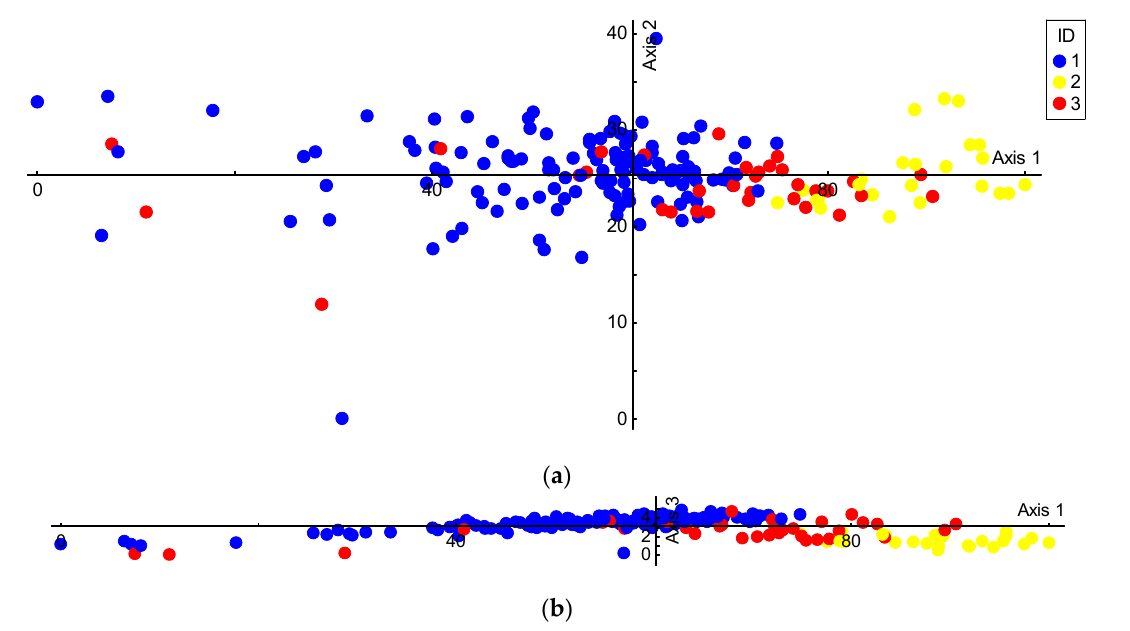
Figure 6. Ordination plots (PCAs) of six leaf morphology traits of alder species. ( a ) Distribution of trees on axes 1 and 2; ( b ) distribution of trees on axes 1 and 3. Species ID: 1— Alnus glutinosa , 2— A. incana , 3— A. × hybrid.